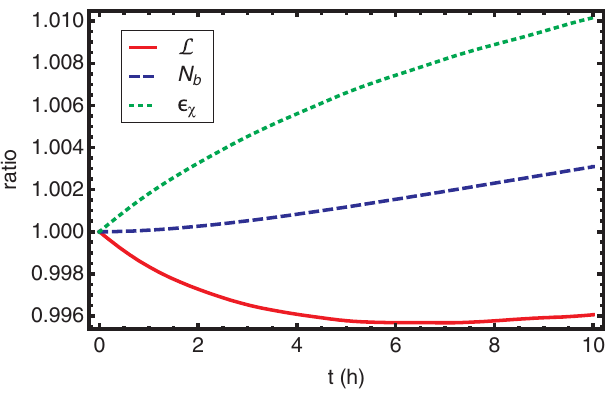
FIG. 13. (Color) The ratio of the quantities calculated using MAD-X for IBS to the ones where the modified Piwinski model was used. The time dependence was solved with the ODE method assuming the LHC collision scheme (numerical parame- ters are shown in Table I), with three experiments